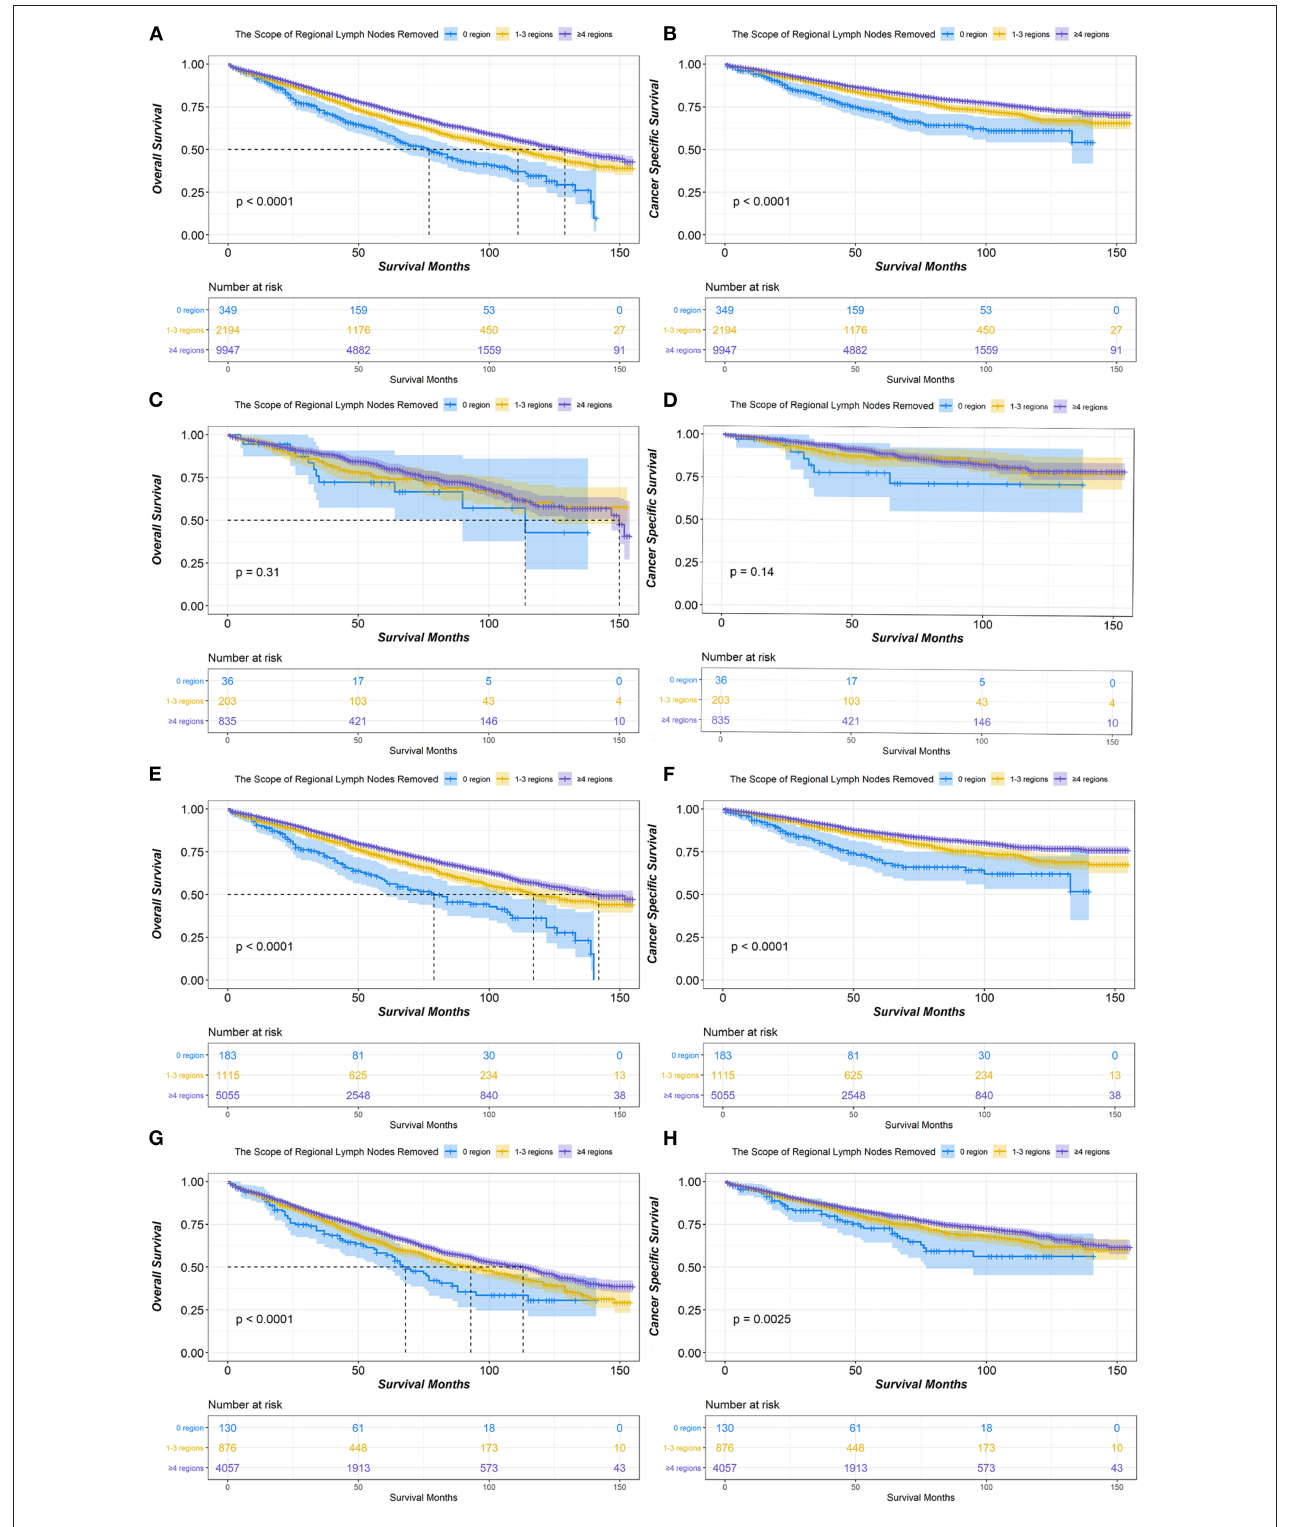
FIGURE 2 | Kaplan-Meier survival curves of the scope of regional lymph nodes removed in IA non-small cell lung cancer (NSCLC) patients who underwent lobectomy or bilobectomy. Overall survival comparison among 0, 1–3, and ≥ 4 regions of lymph nodes removed in stage IA (A) NSCLC patients including T1a (C) , T1b (E) , and T1c (G) . Cancer-specific survival comparison among 0, 1–3, and ≥ 4 regions of lymph nodes removed in stage IA (B) NSCLC patients including T1a (D) , T1b (F) , and T1c (H) .